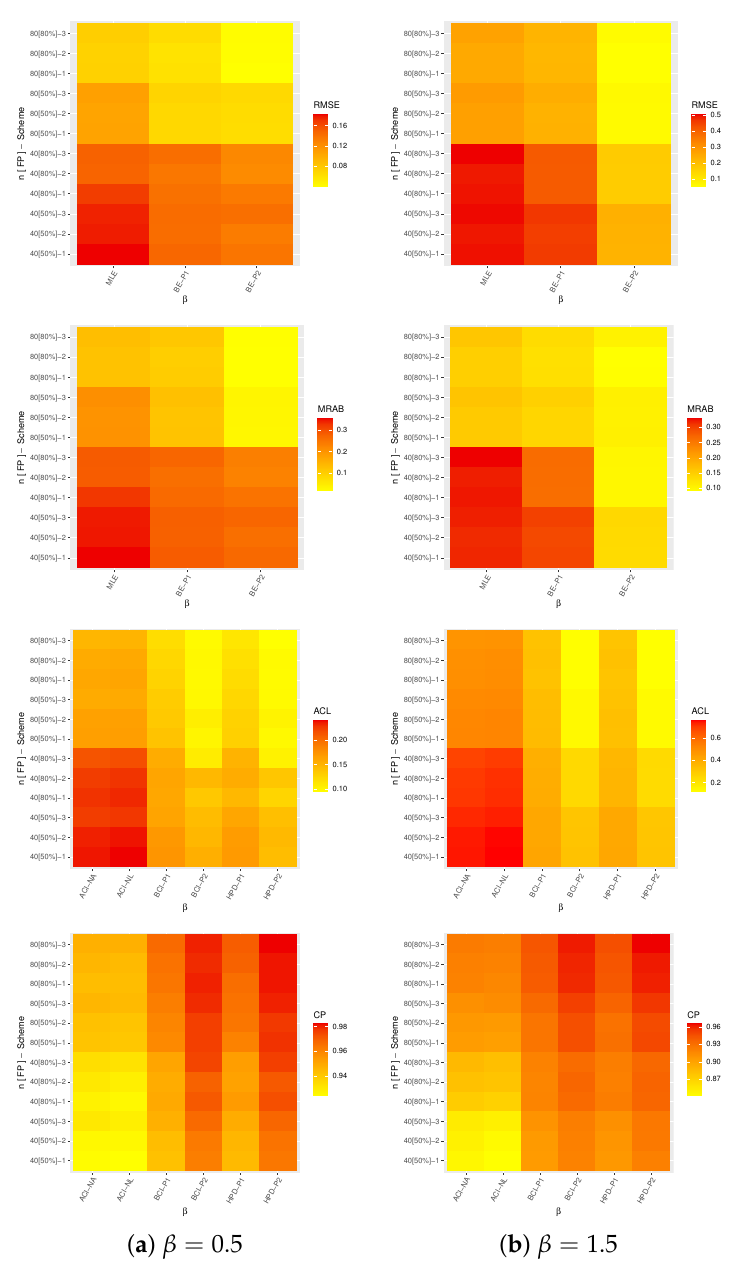
Figure 3. Heat-map for the Monte Carlo results of β